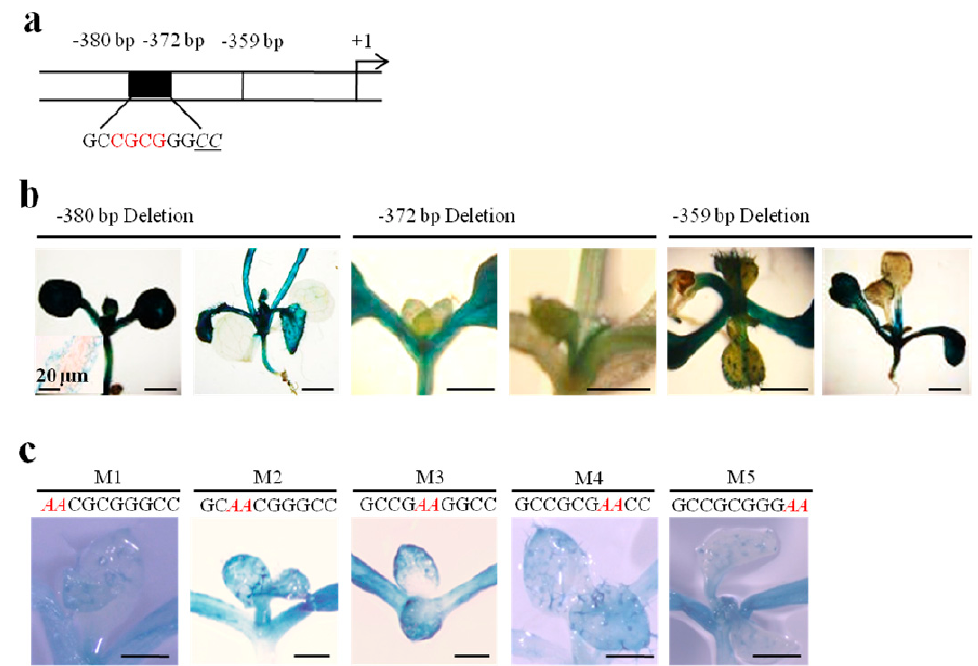
Figure 3. Activities of TaLTP1 promoter deletion and mutation series in transgenic A. thaliana. Identification of a GC(N4)GGCC motif that regulates pavement cell-specific expression. ( a ) Diagram of the GC(N4)GGCC box located within the upstream sequence of TaLTP1 ; ( b ) Histochemical analysis of GUS activity of TaLTP1 promoter deletion mutants at positions − 380 bp, − 372 bp and − 359